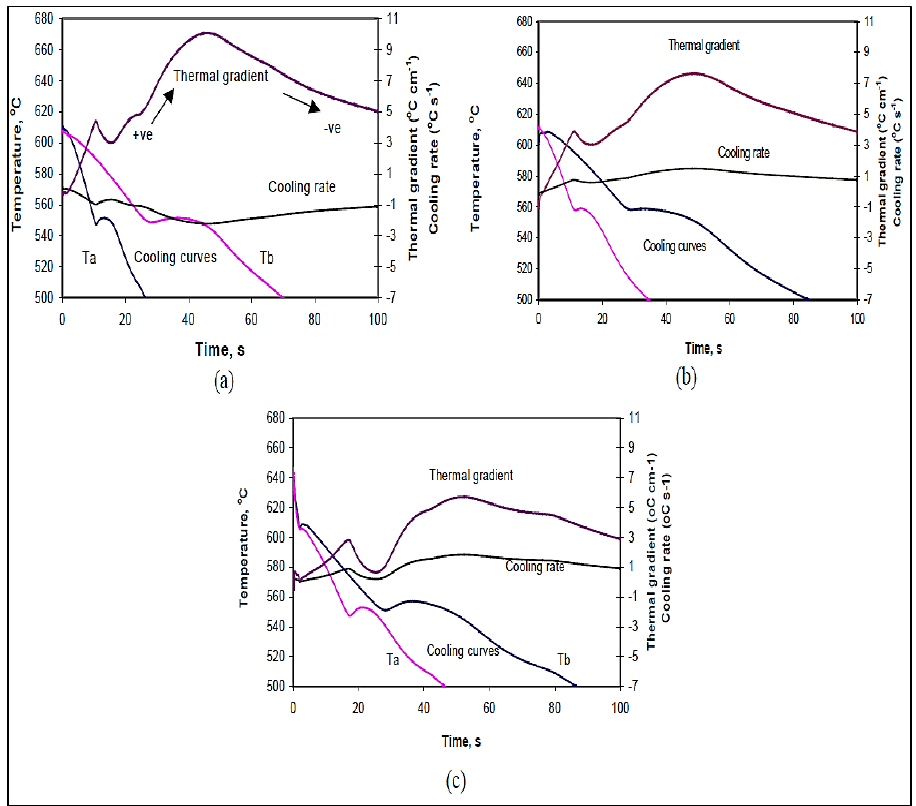
Figure 16. Comparison of temperature, thermal gradient, and solidification rates versus time for ( a ) B (Sr-modified 319), ( b ) BB2 (B + 2186 ppm Bi), and ( c ) BC2 (B + 103 ppm Ca) alloys (small mold).